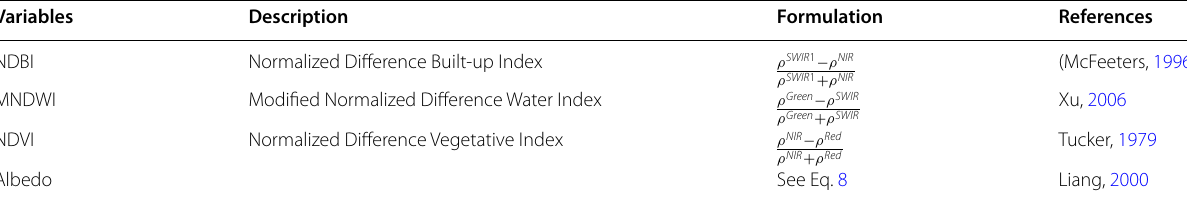
Table 5 Spectral indices selected as explanatory variables of LST and NST